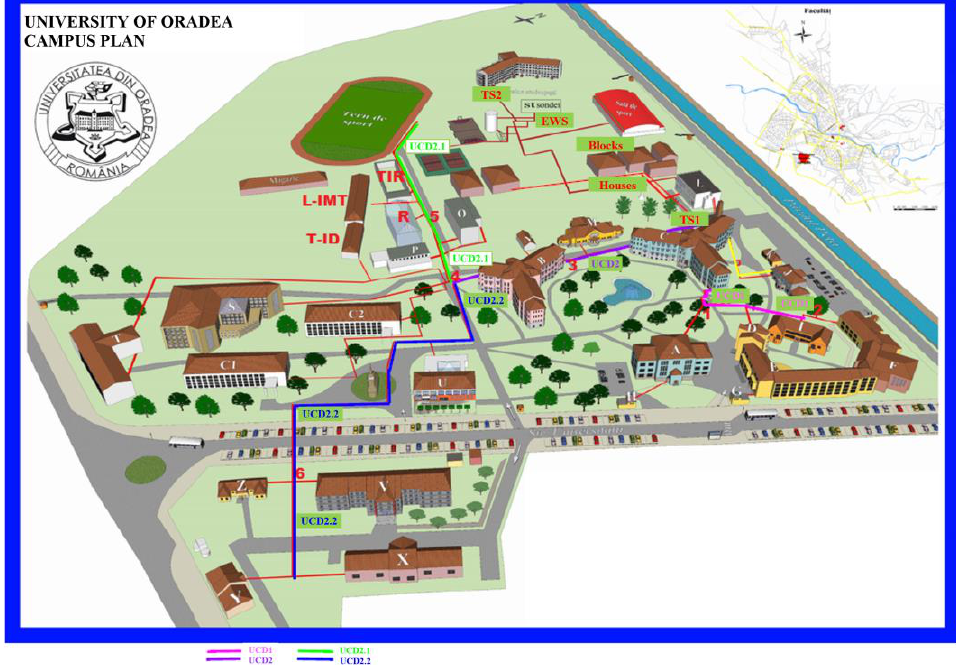
Figure 4. UO central campus plan and HSGWPE components.